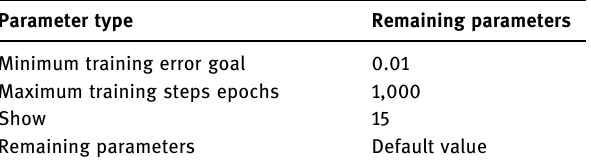
Table 2: Results of training parameter settings Parameter type